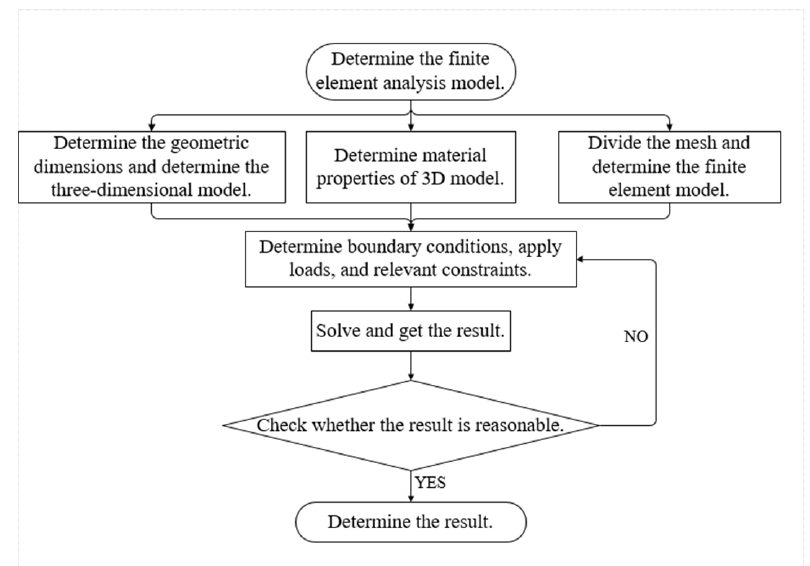
Figure 2. Flow chart of finite element simulation analysis.